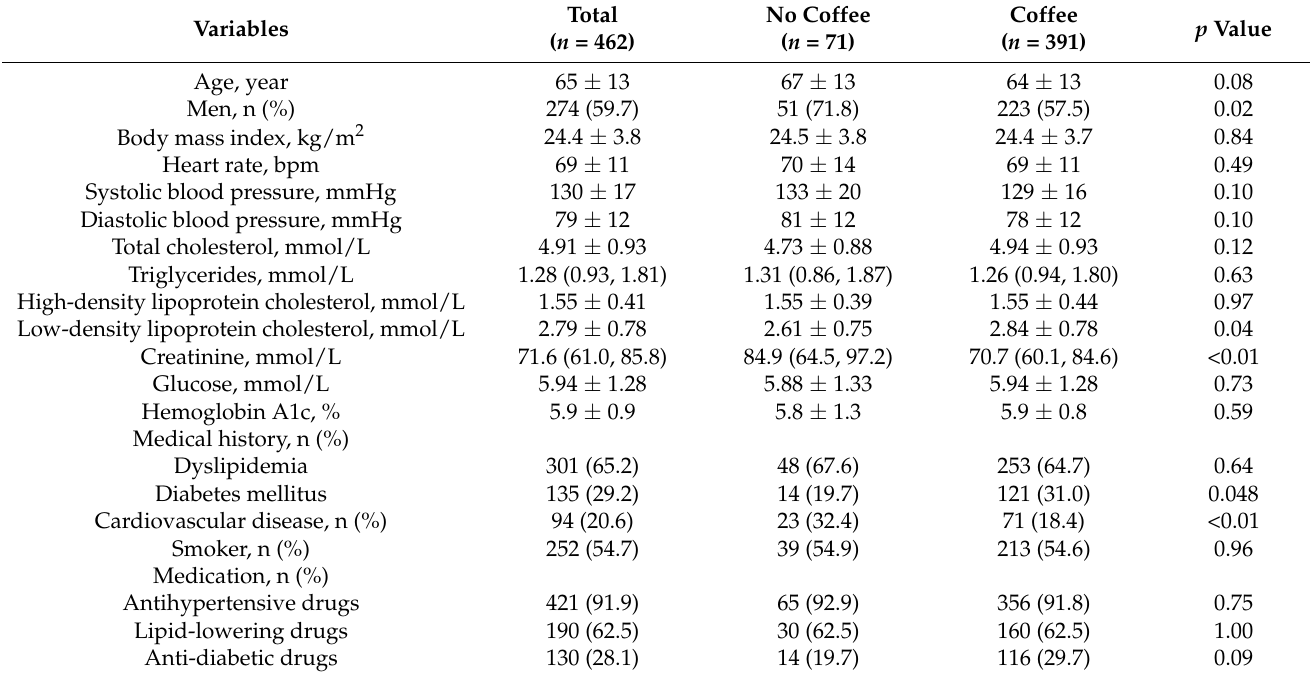
Table 1. Clinical Characteristics of Subjects in Groups According to Daily Coffee